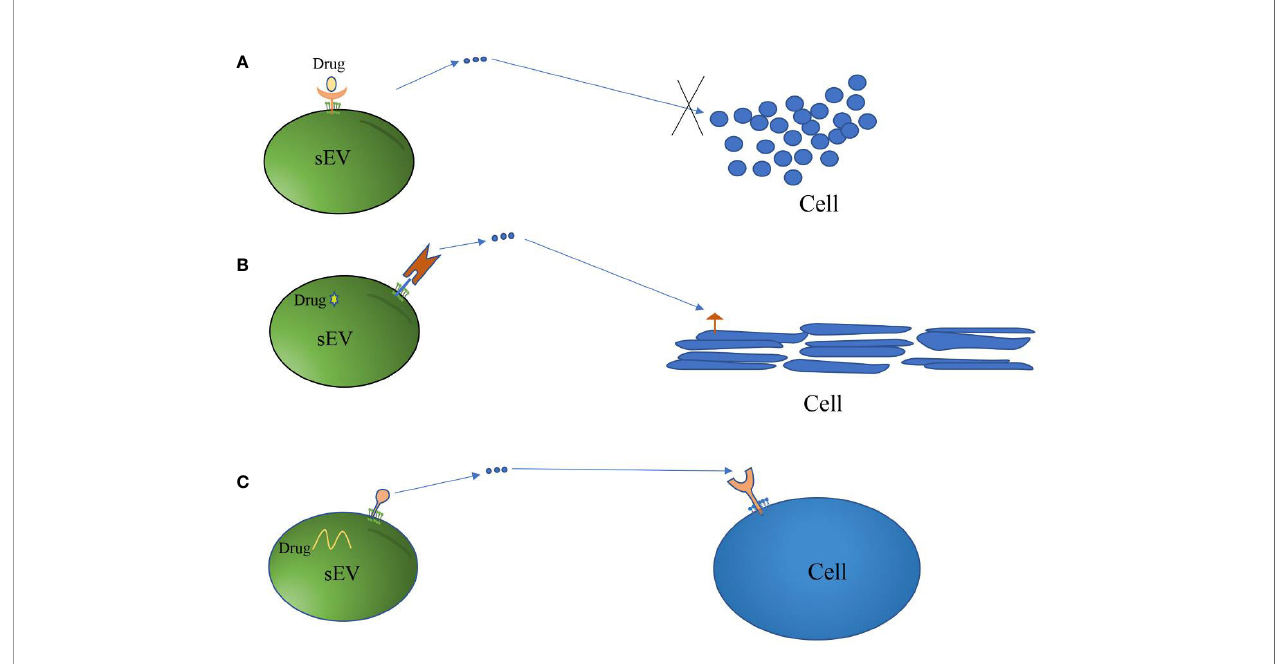
FIGURE 2 | Mechanisms of sEV membrane proteins involved in targeted therapy. (A) Some sEV membrane proteins derived from tumor cells act as receptors of drugs. These drugs inhibit the growth or metastasis of cancer cells by blocking sEV-mediated information transmission. (B) sEV membrane proteins are linked to cell-speci fi c proteins or peptides that target sEV carrying therapeutic drugs to speci fi c cells, thereby achieving the purpose of targeted therapy. (C) sEV membrane proteins act as ligands to guide sEV carrying therapeutic drugs or having therapeutic effects to target speci fi c cells, thus achieving the purpose of